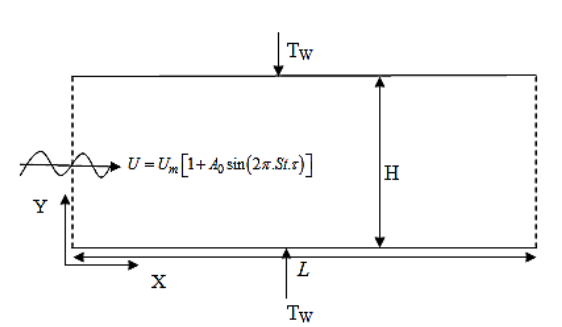
Fig.1. Schematic of Physical Domain The flow enters from left-hand side with an oscillating flat velocity profile and exits from the right hand side of the physical domain. The flow is unsteady, laminar, and carries the nanoparticles. The nanoparticles and the base fluid (water) are assumed to be in a thermal equilibrium and no slip condition occurs between them. Also the body forces, radiation heat transfer and viscous dissipation are neglected in this